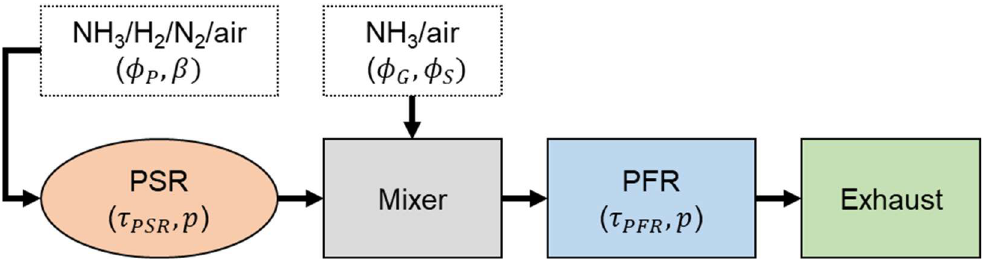
Figure 1. Schematic diagram of the CRN model of the partially cracked ammonia combustor with staged injection.